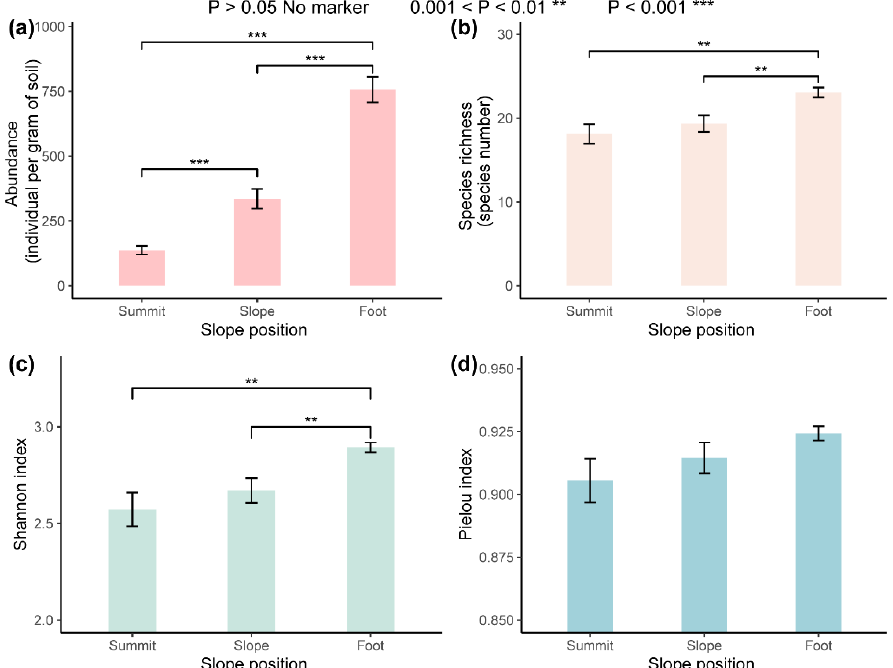
Figure 8. Overall community characteristics (mean ± SE) of the TA communities at the three slope positions [( a ) The abundance of TA communities at the three slope positions; ( b ) The species richness of TA communities at the three slope positions; ( c ) The Shannon’s diversity index of TA communities at the three slope positions; ( d ) The Pielou’s evenness index of TA communities at the three slope positions].